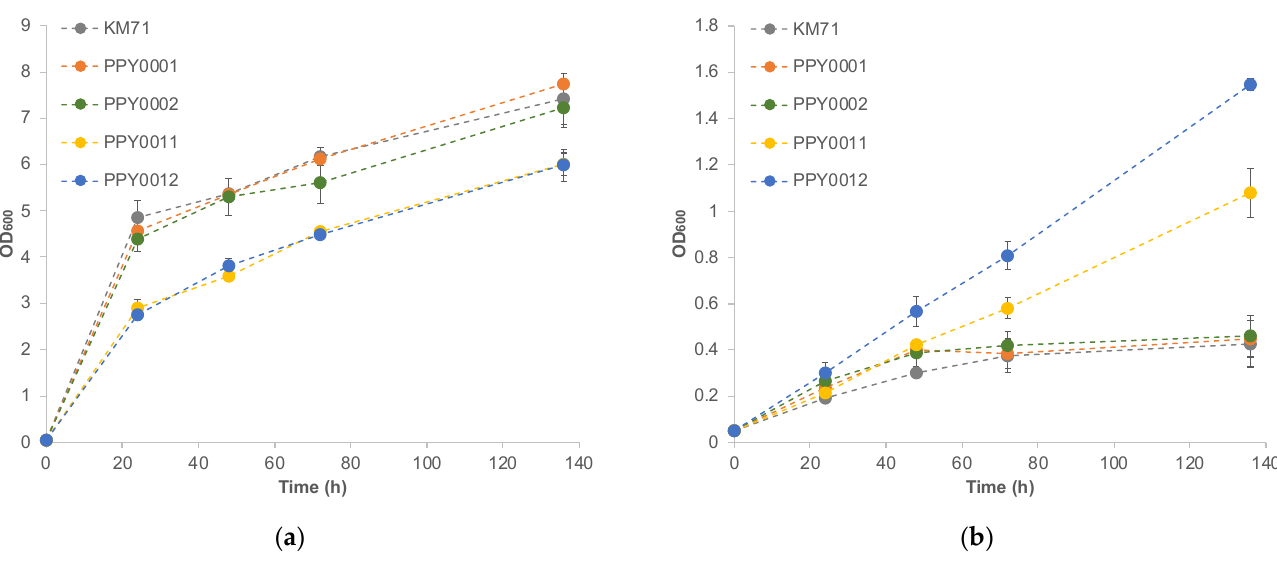
Figure 2. Growth profile of engineered P. pastoris strains in ( a ) MGYH-glu minimal medium con- taining 2% glucose as the sole carbon source and ( b ) MXYH minimal medium containing 2% xylose as the sole carbon source. Please note that the specific growth rates of the engineered strains were obtained using the BioLector microfermenter (m2p labs) and are listed in Table 1.